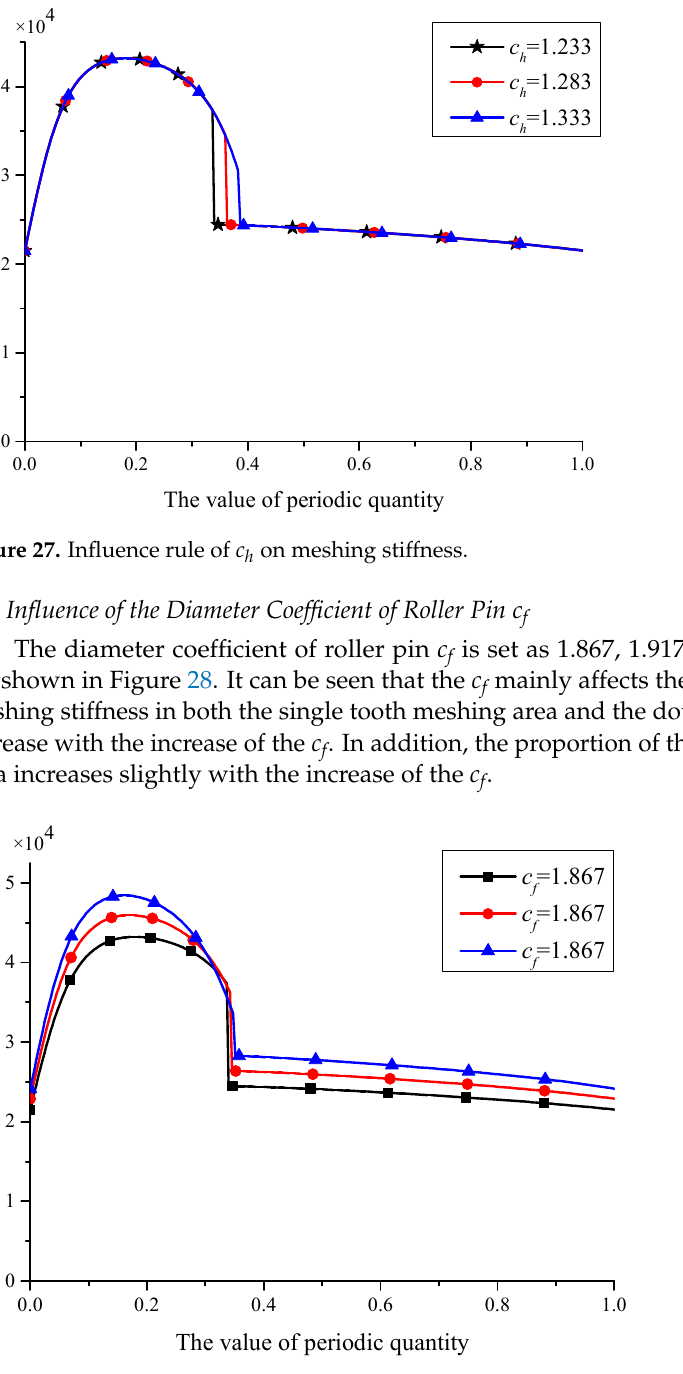
Figure 28. Influence rule of c f on meshing stiffness.